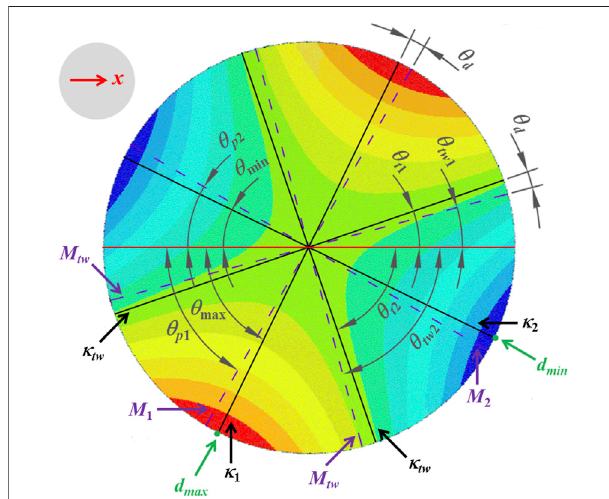
FIGURE 5 | Diagram of principal moments and curvatures, the maximum twisting moment and curvature, and the de fl ection angle. d max and d min denote the maximum and minimum displacements, respectively. The black solid lines are the principal curvatures, κ 1 and κ 2 , the maximum twisting curvature, κ tw , and the corresponding directions are the maximum andminimumprincipalcurvaturedirections, θ max and θ min ,andthedirectionof themaximumtwistingcurvatures, θ tw 1 and θ tw 2 ;thepurpledottedlinesarethe principal moments, M 1 and M 2 , the maximum twisting moment, M tw , and the corresponding directions are the maximum and minimum principal moment directions, θ p 1 and θ p 2 , and the directions of the maximum twisting curvature, θ θ t 1 and t 2 .